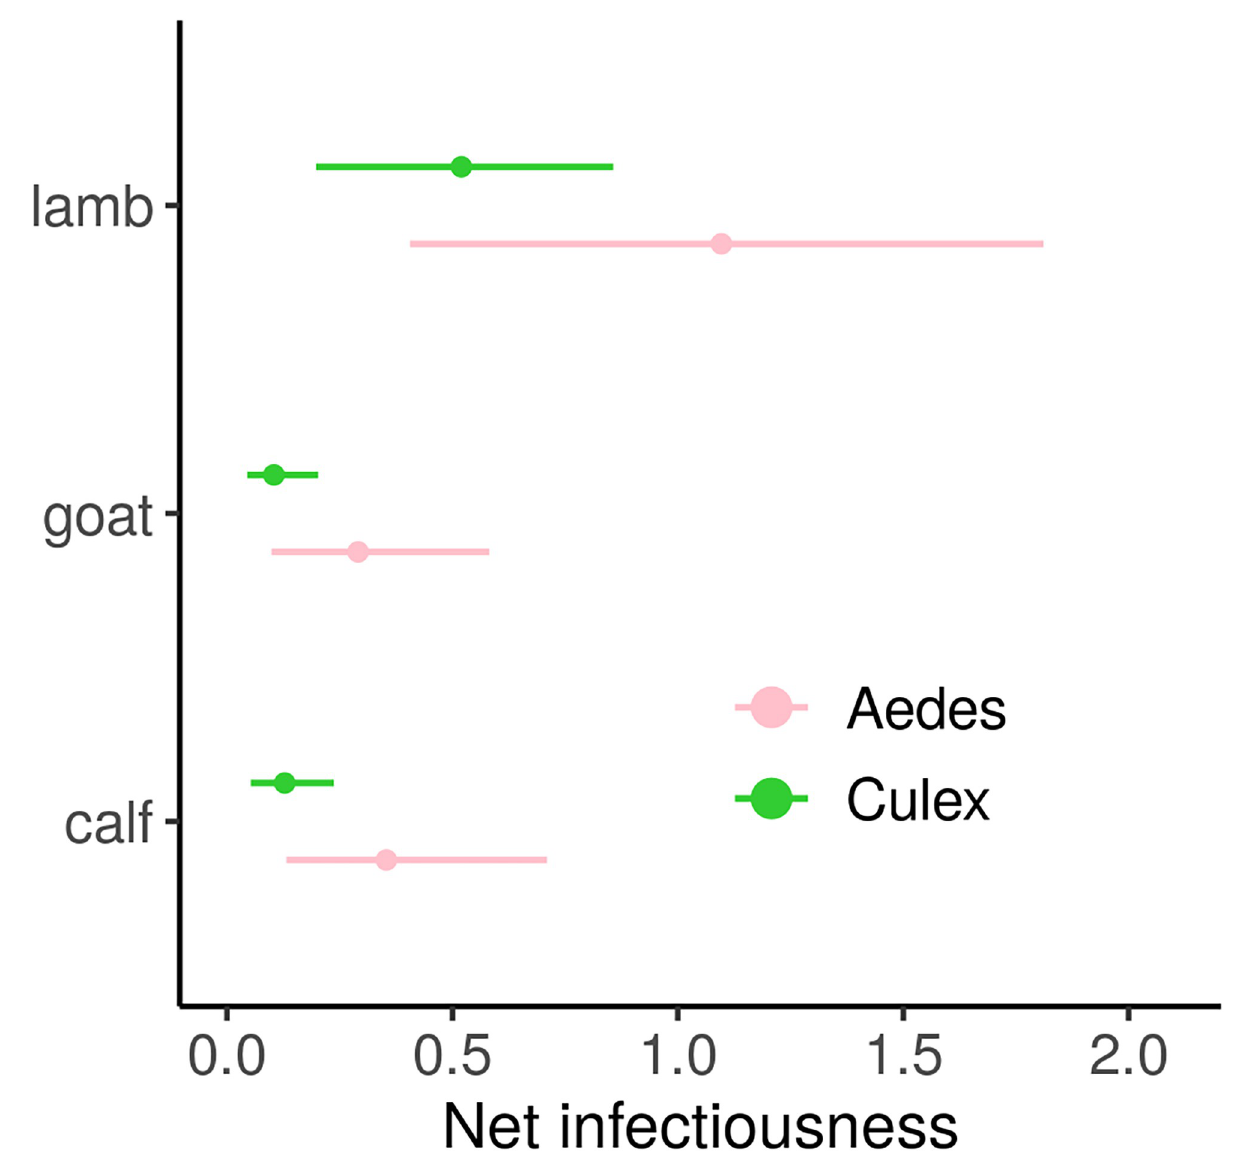
Fig 5. Net infectiousness of RVFV livestock host species, function of the mosquito genus involved in transmission. Points are median estimates, lines show highest density intervals, computed using 1000 parameter sets from the within-host model and dose-response curve respective fitting procedures. For lambs, parameters were sampled in the posteriors of both surviving and dying groups, according to the survival rate observed in the original dataset (6/16, Fig H in S1 Text). Time of death also varied according to a Weibull survival model (Materials and